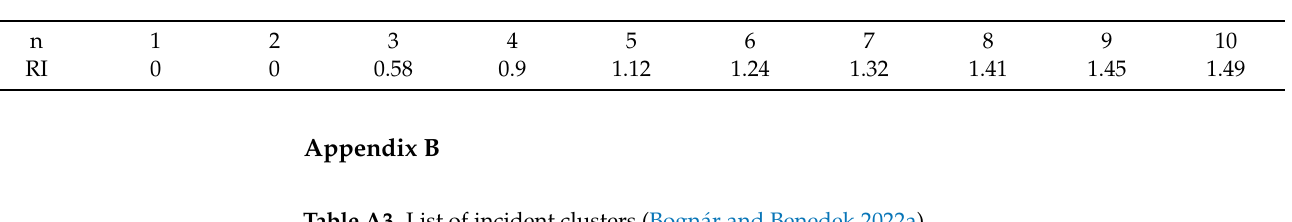
Table A2. Random indexes related to different numbers of alternatives (n) (Ok et al. 2022).